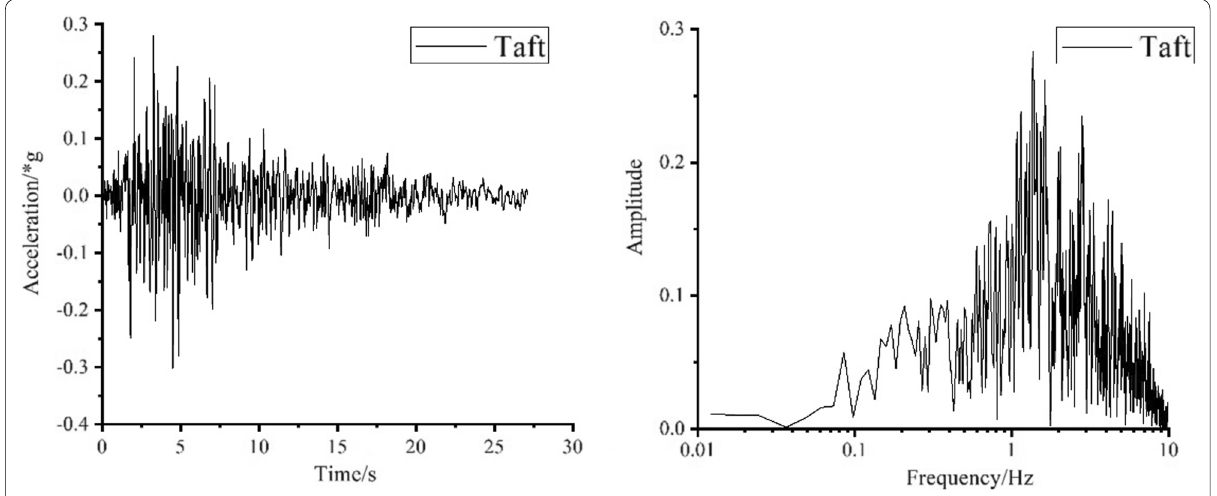
Fig. 4 Time history curve and Fourier spectrum of Taft ground motion